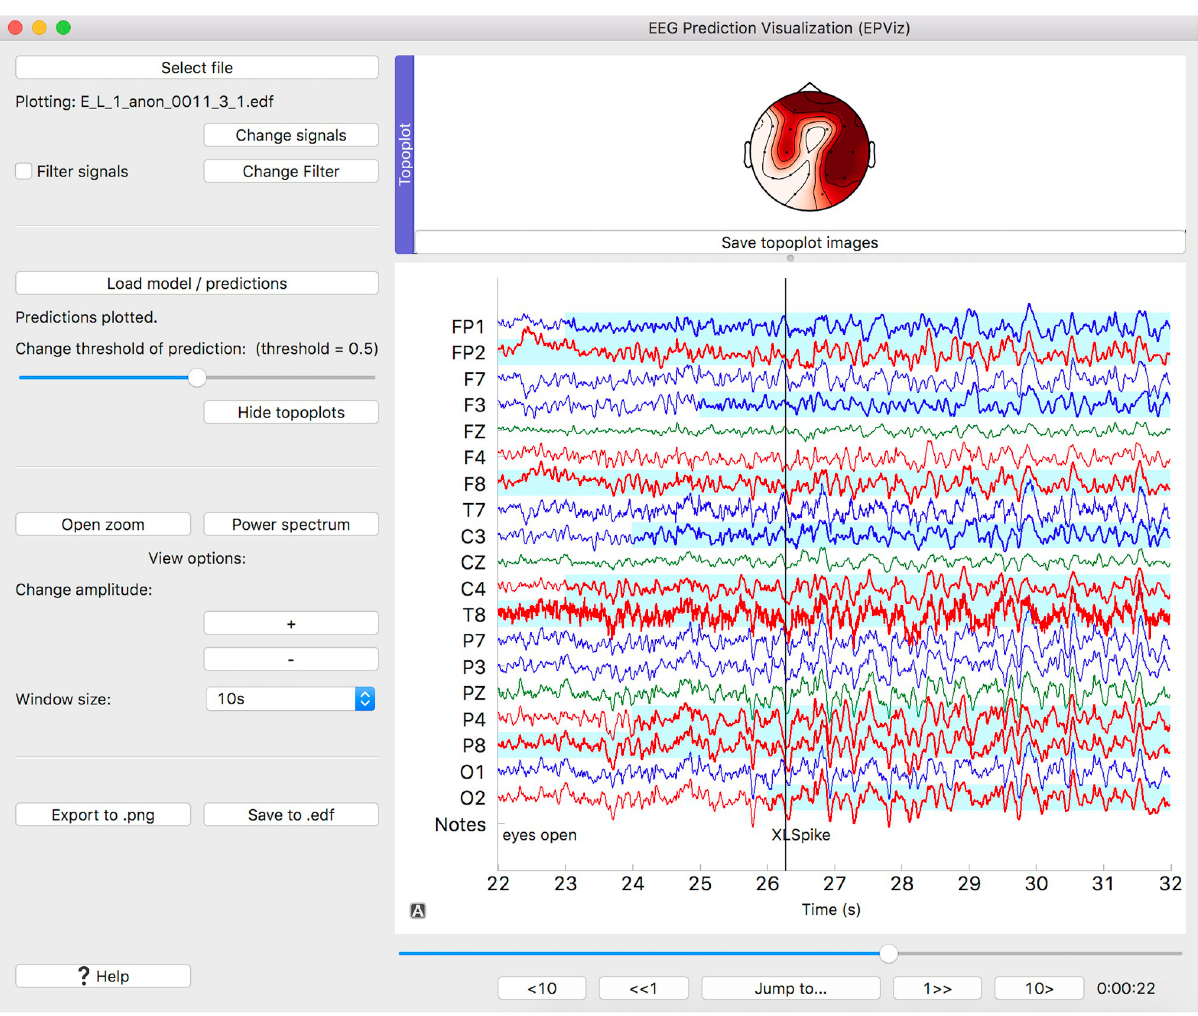
Fig 2. Visualizing predictions. Model predictions are shown in light cyan across the channels. Since multi-channel predictions are plotted, topoplots have been generated.